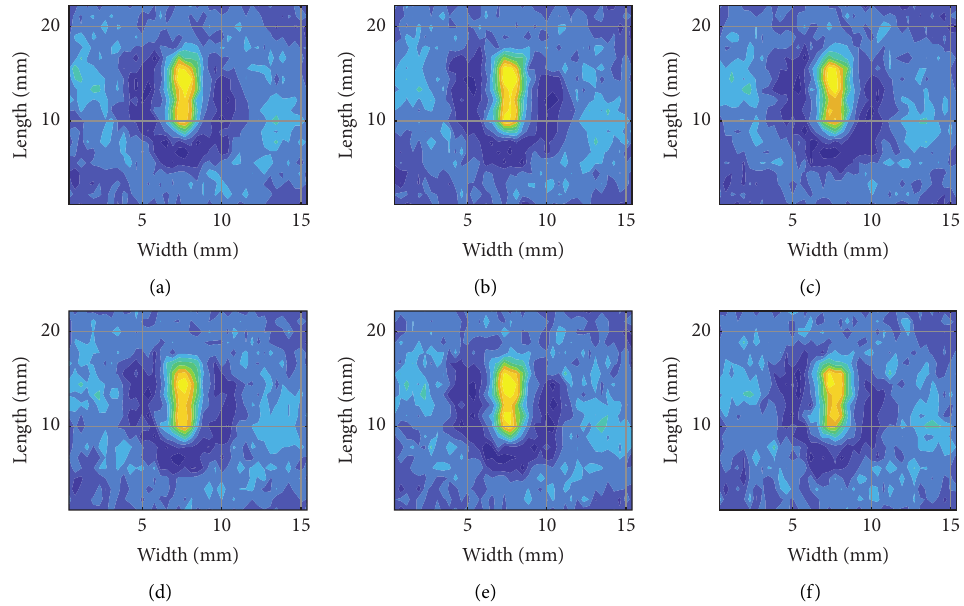
Figure 10: Real-part imaging of C8 defect with different noise effects. (a) SNR � 95dB. (b) SNR � 90dB. (c) SNR � 80dB. (d) SNR � 70dB. (e) SNR � 60dB. (f) SNR � 50 dB.